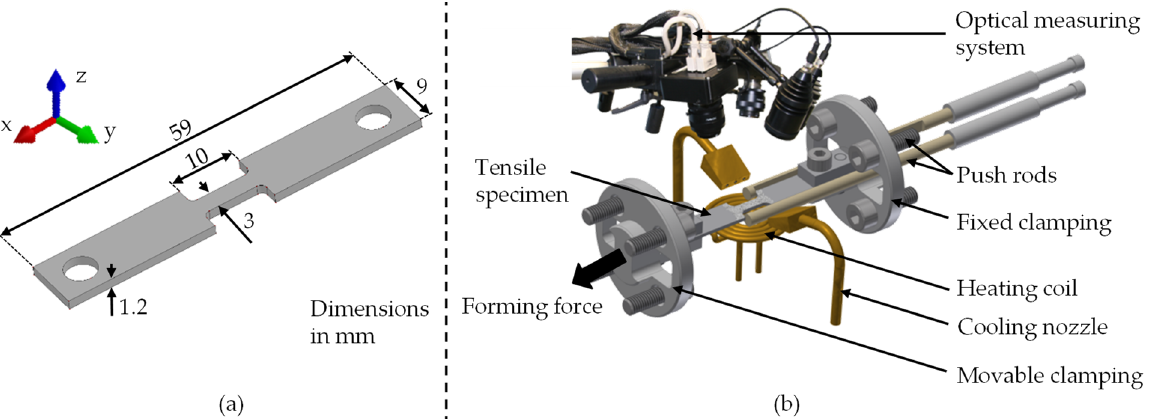
Figure 1. Miniature tensile test specimen geometry ( a ); and the experimental setup of the quenching and forming dilatometer with an optical measuring system ( b ).